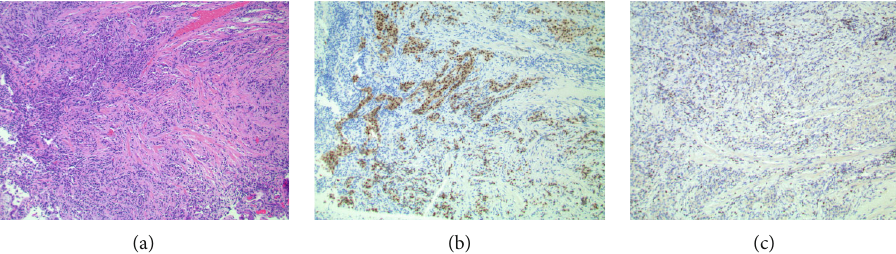
Figure 2: NKX3.1 distinguishes prostatic origin amidst signi fi cant cautery artifact. (a) Tumor cells can be seen in fi ltrating through smooth muscle tissue, which appear epithelioid, but otherwise show no distinguishing features. These tumor cells are in a background of in fl ammation and appear cauterized, making it di ffi cult to classify based on morphology alone. (b) The immunohistochemical stain NKX3.1 shows strong nuclear positivity in the tumor cells. In contrast (c), the larger tumor cell nuclei are negative for the immunohistochemical stain GATA3 and only show nonspeci fi c faint blushing of the cytoplasm. GATA3 is appropriately positive in an occasional small background of benign lymphocyte